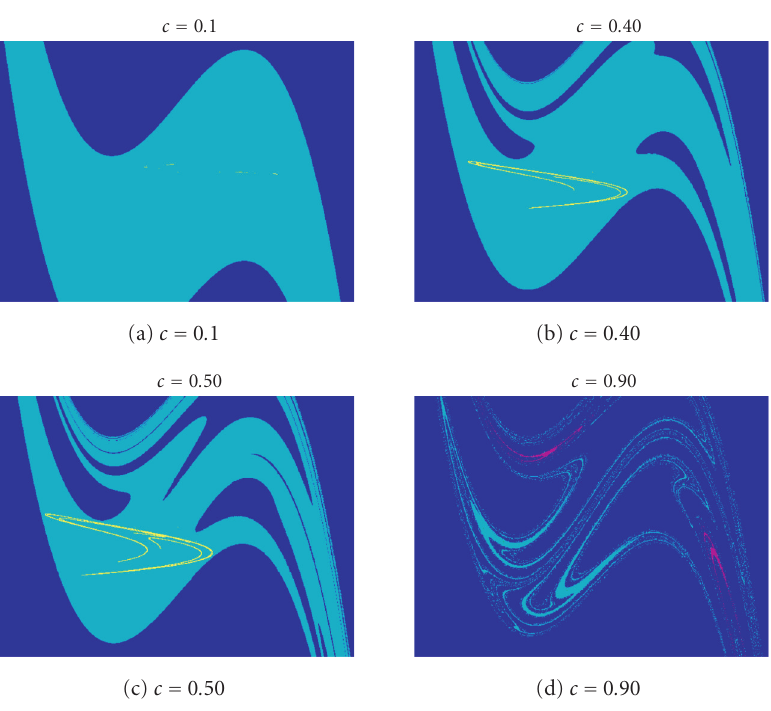
Figure 3.1. Destruction of the chaotic area and its basin after a contact